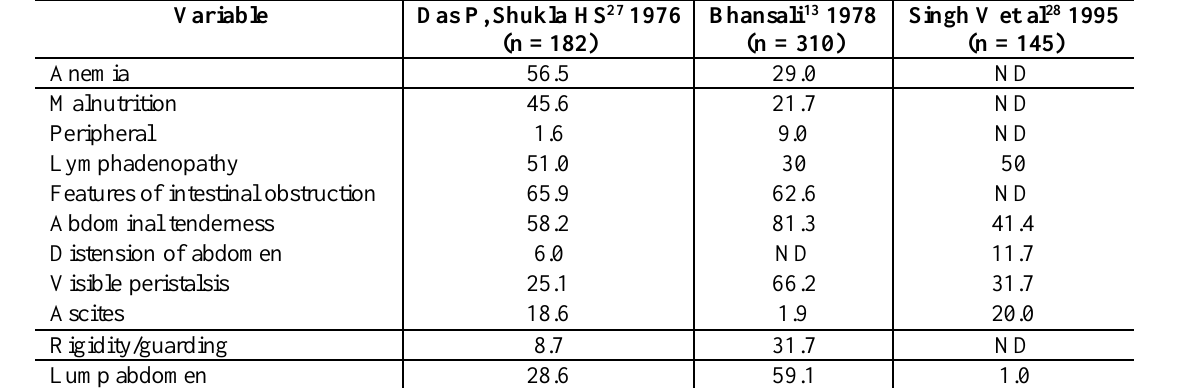
Table III : Clinical features in abdominal TB (percent) Symptoms and